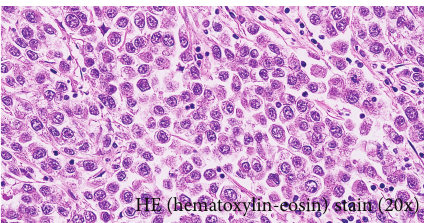
Figure 2: Hematoxylin-eosin staining shows large, oval tumor cells with clear, round nuclei and clear cytoplasm. The tumor was histologically diagnosed as seminoma. Immunological staining showed positive results for placental alkaline phosphatase and C-kit but negative results for AFP and HCG. CD20 and CD3, as markers of lymphoma, were also